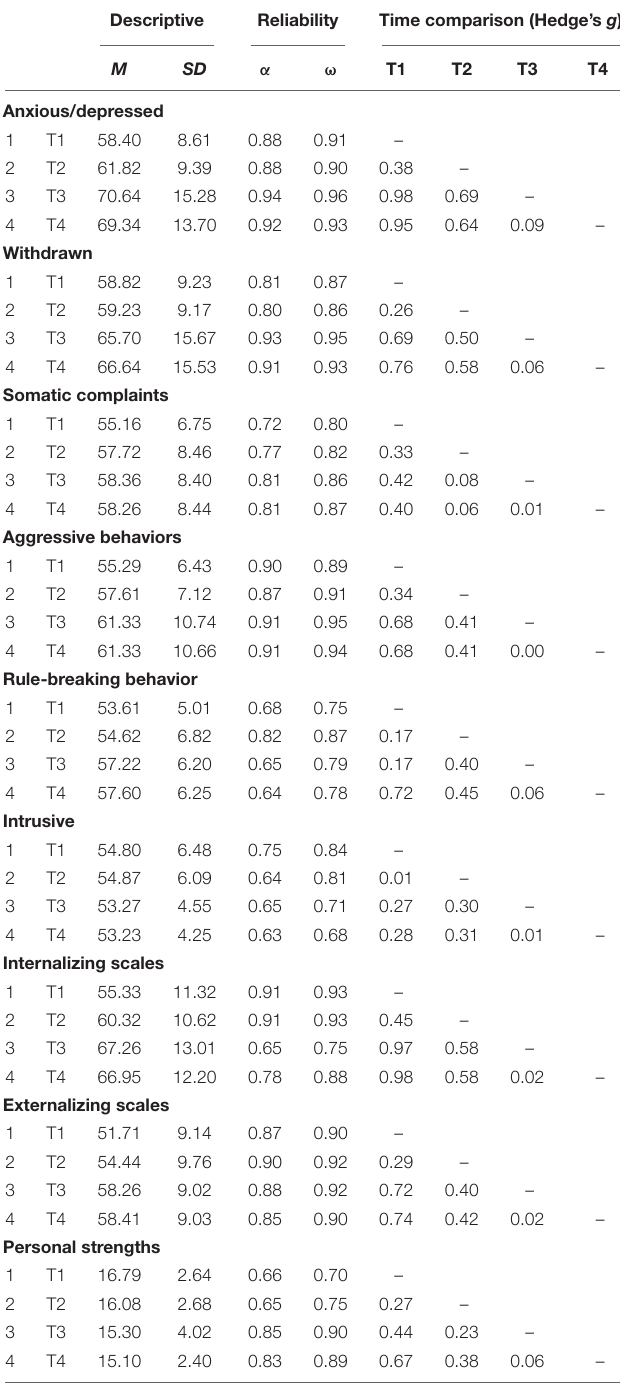
TABLE 1 | Mean, standard deviation, reliability coefficients, and effect size (|g|) for each time comparison. Descriptive Reliability Time comparison (Hedge’s g